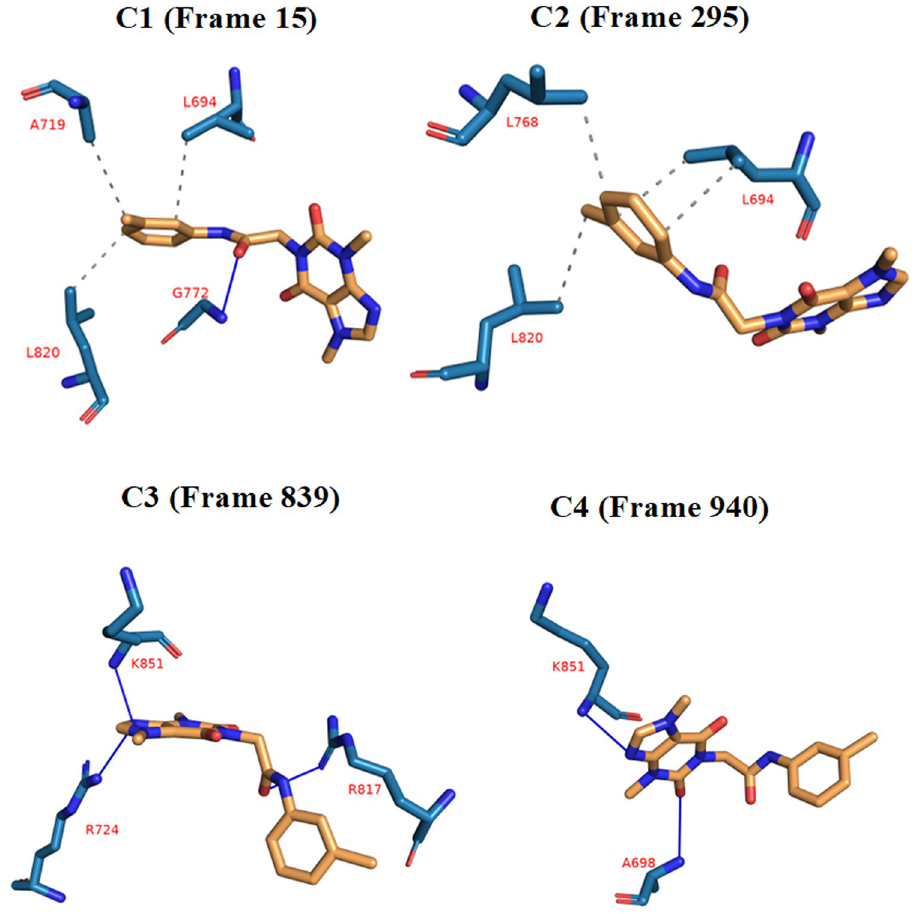
Fig 11. The variation (types and numbers) of interactions of the EGFR_T-1-MTA complex produced from PLIP. HB: Blue solid line, HI: Dashed grey line, green dashed lines: Pi-Stacking interaction, amino acids: Blue sticks, and T- 1-MTA : Orange